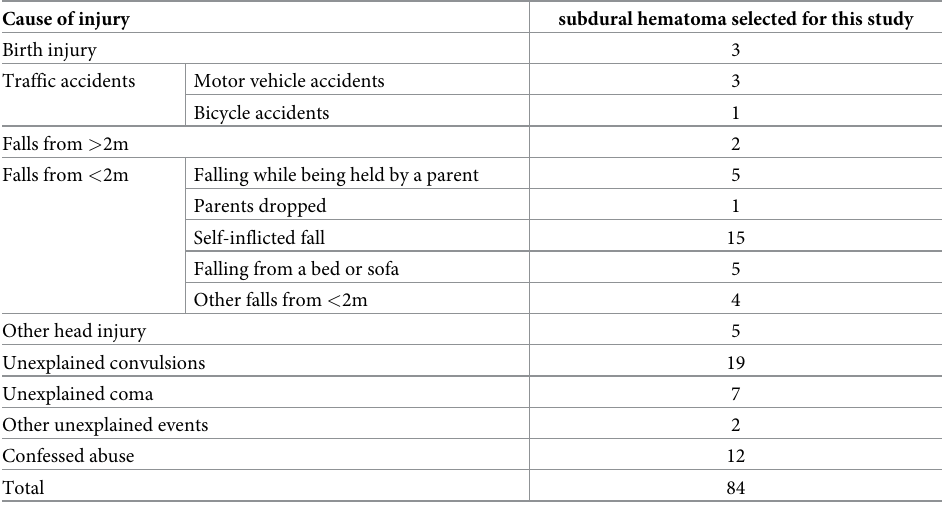
Table 2. The injury mechanism classification of 84 cases included in the present